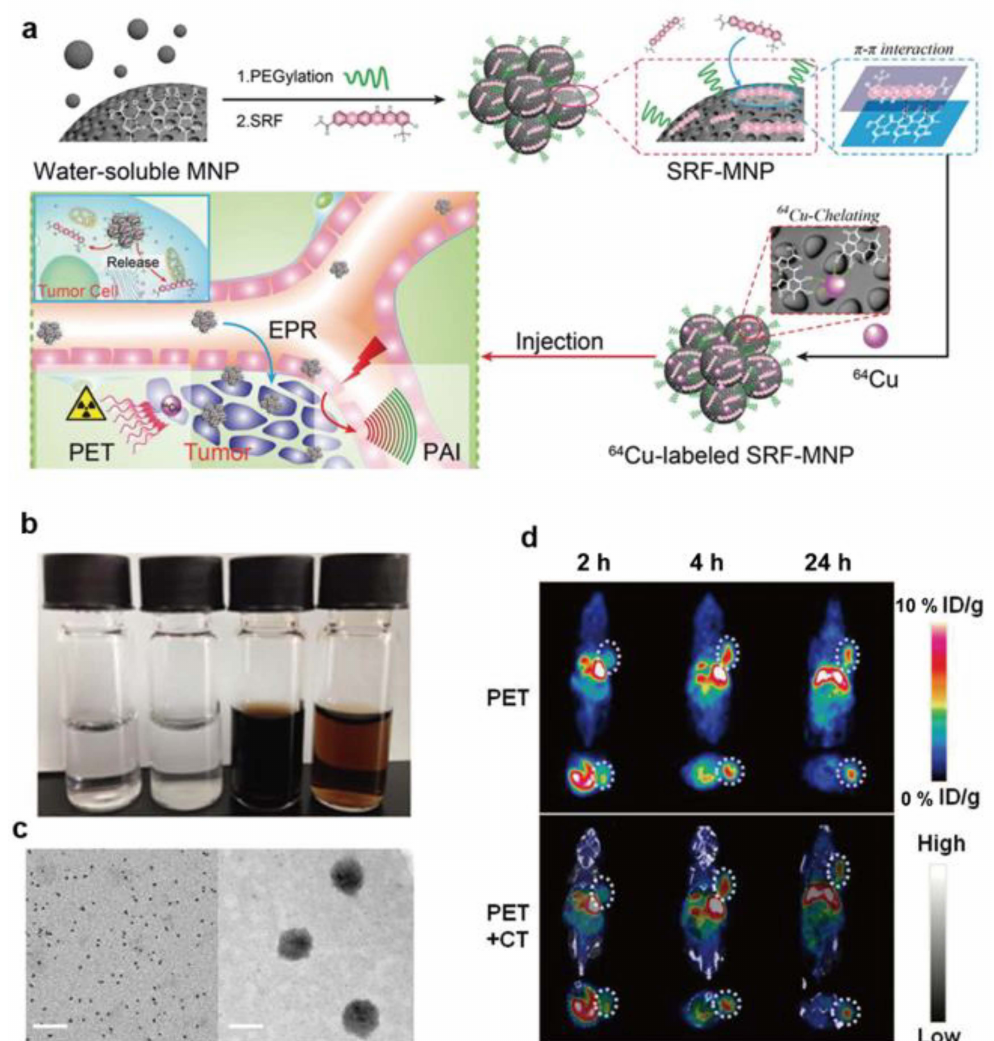
Figure 7. The preparation of 64 Cu 2+ chelated SRF-MNPs and in vivo PET images of nanoparticles. ( a ) Schematic illustration of the preparation of SRP-MNPs and therapy process in vivo. ( b ) The photographs of different groups (from left to right): (1) pure water, (2) SRF precipitated in PBS, (3) PEG-MNP dispersed in PBS, and (4) SRF dispersed in PBS having PEG-MNP. ( c ) TEM of PEG-MNP (left) and SRF-MNP (right), scale bar = 50 nm. ( d ) Representative decay-corrected coronal (top) and transaxial (bottom) small-animal PET images and overlaid CT and PET images of HepG2 tumor (region enveloped by white dotted line) acquired at different times post injection with 64 Cu 2+ chelated SRF-MNPs